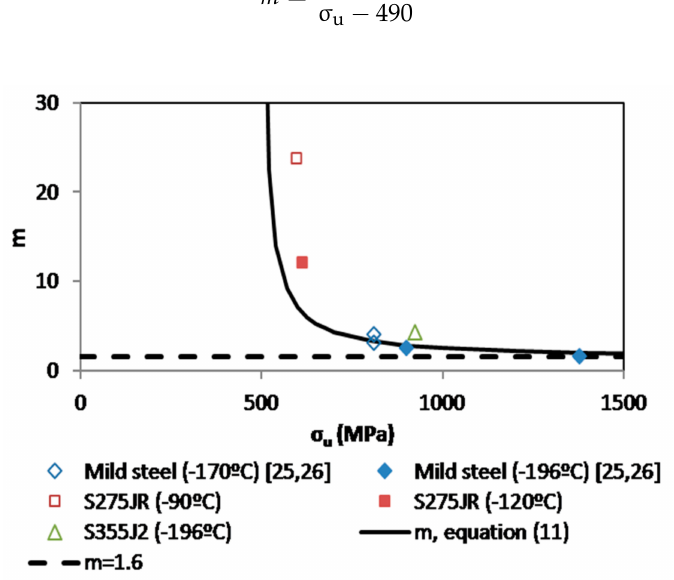
Figure 2. m values versus tensile strength for structural steels operating at the Lower